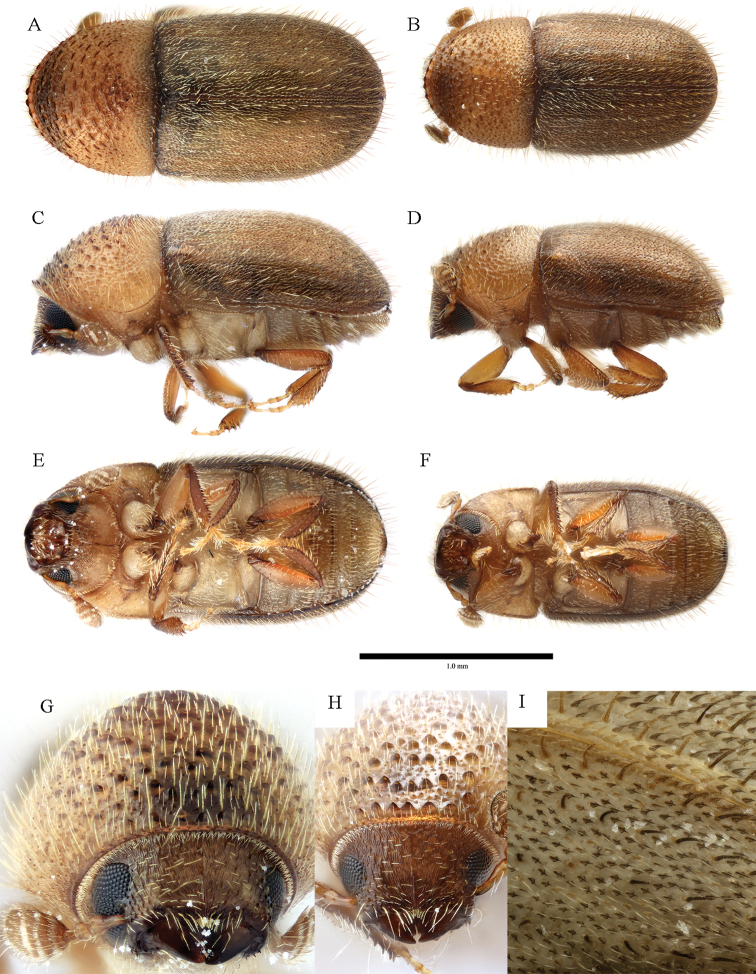
Cryphalus
meridionalisA, C, E, G female, UFFE:28062 B, D, F, H male, UFFE:34962 I female, UFFE:33236.